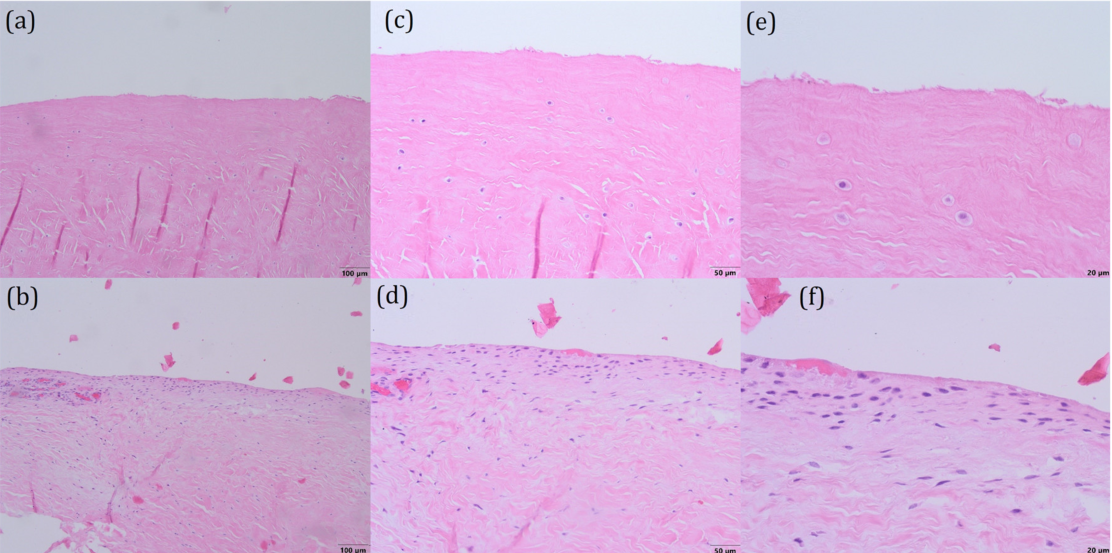
Figure 4. Histological and immunohistochemical evaluation of menisci stained with hematoxylin and eosin: ( a , b ), magnification 10 × ; ( c , d )—magnification 20 × ; ( e , f )—magnification 40 × ; ( a , c ) and ( e )—Patient No. 1; ( b , d , f )—Patient No.